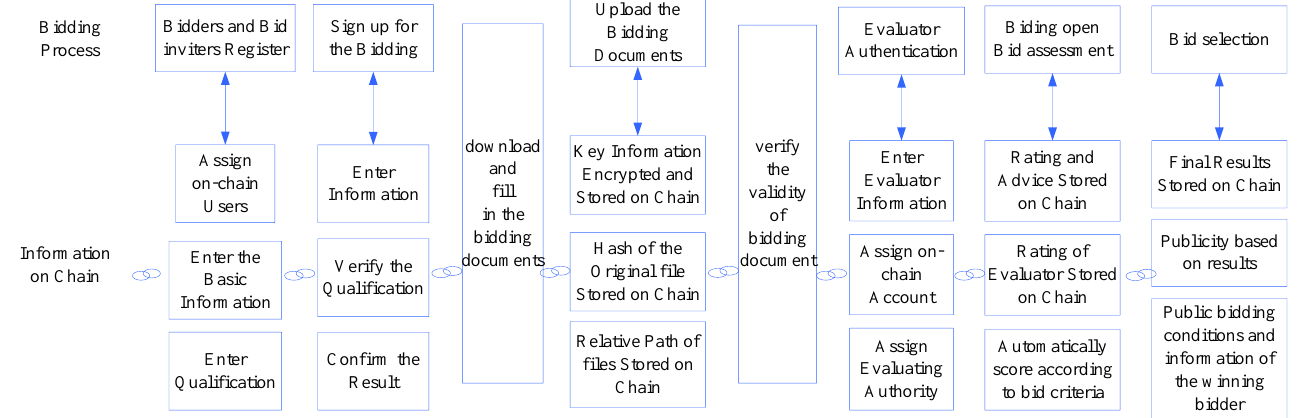
Figure 7. The process of blockchain-based E-bidding service.